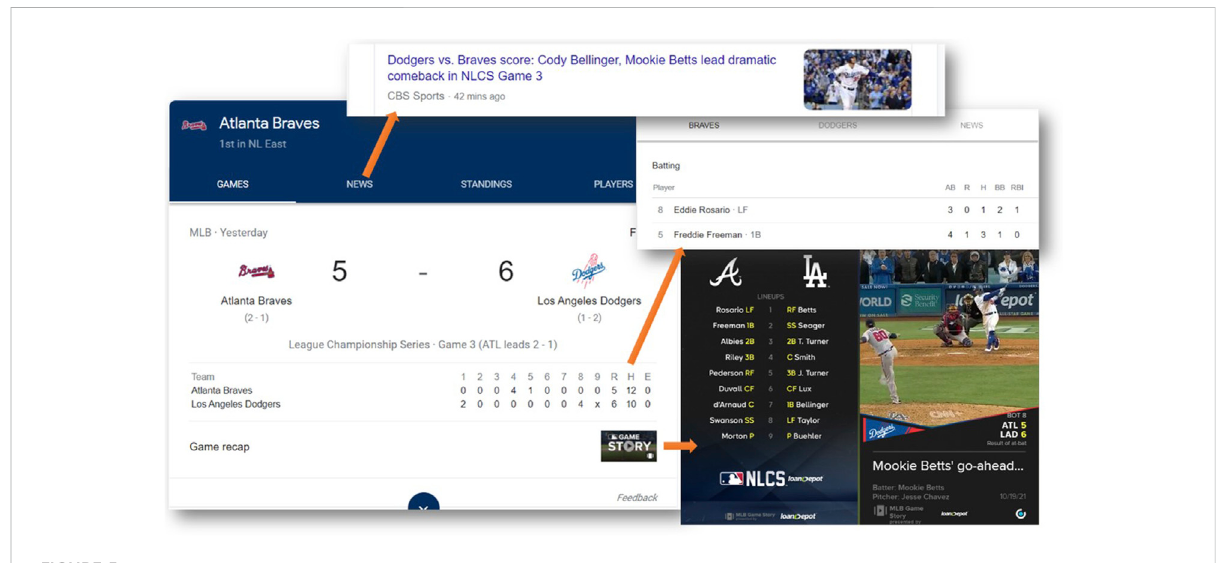
Example representation of CLT in a Google search for “ baseball score ”